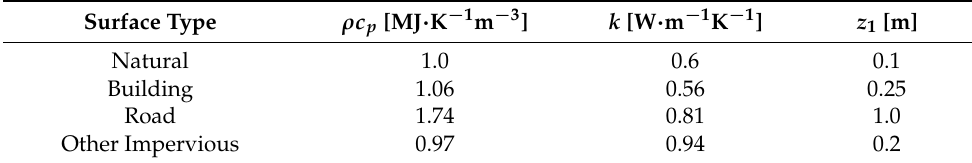
Table 2. Thermal mass parameters input to heat storage